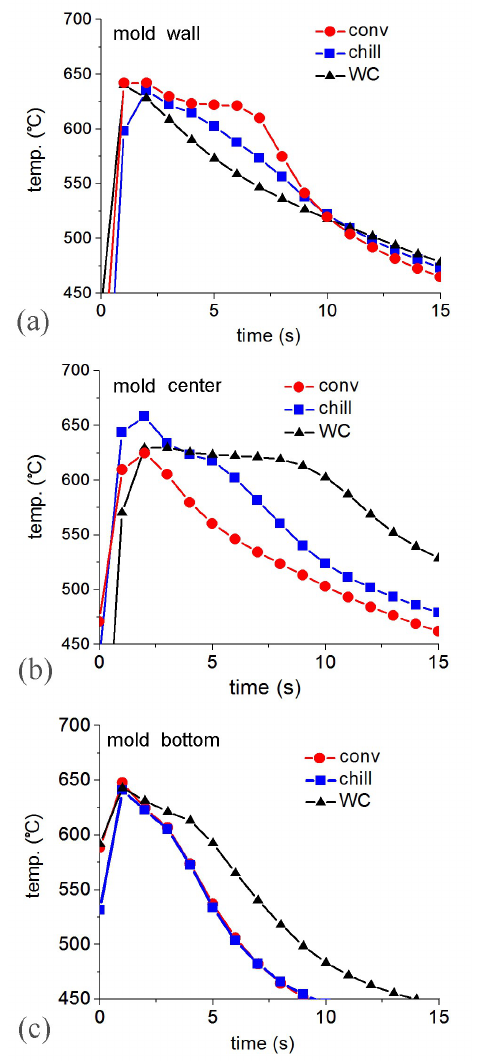
Figure 2. Plots showing cooling rates during solidification in chill casting, conventional and water-cooled mold, at ( a ) the wall, ( b ) center and ( c ) bottom of the